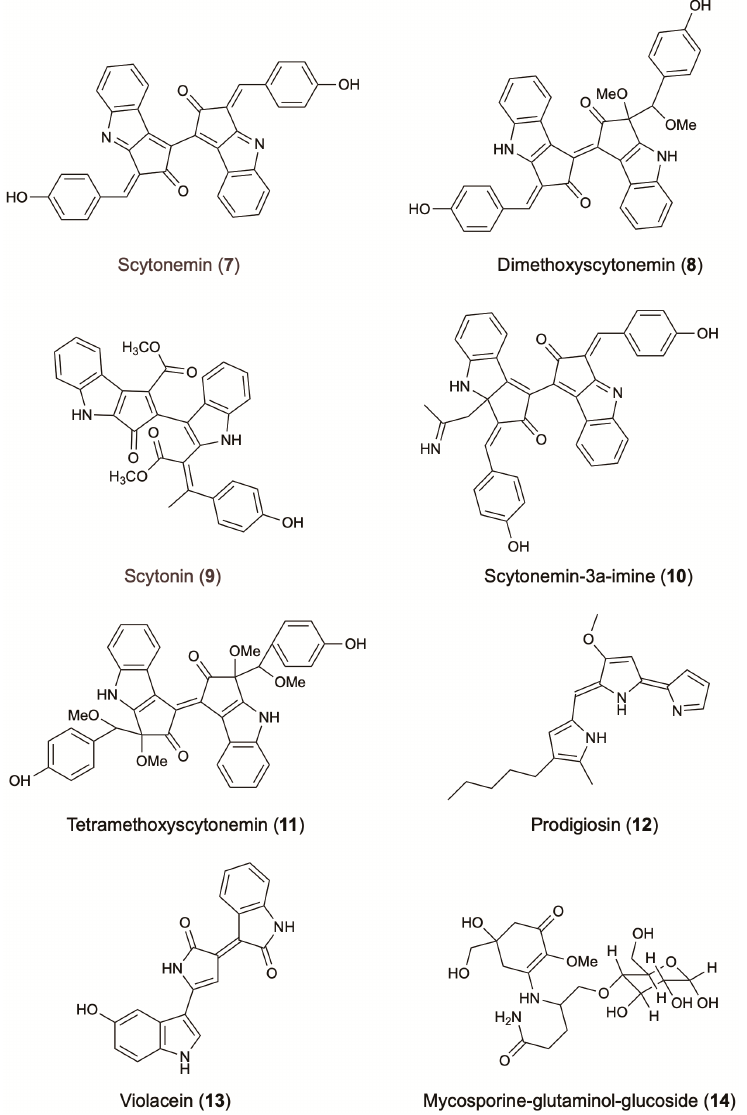
Figure 3. Photo-protective agents from terrestrial microorganisms.